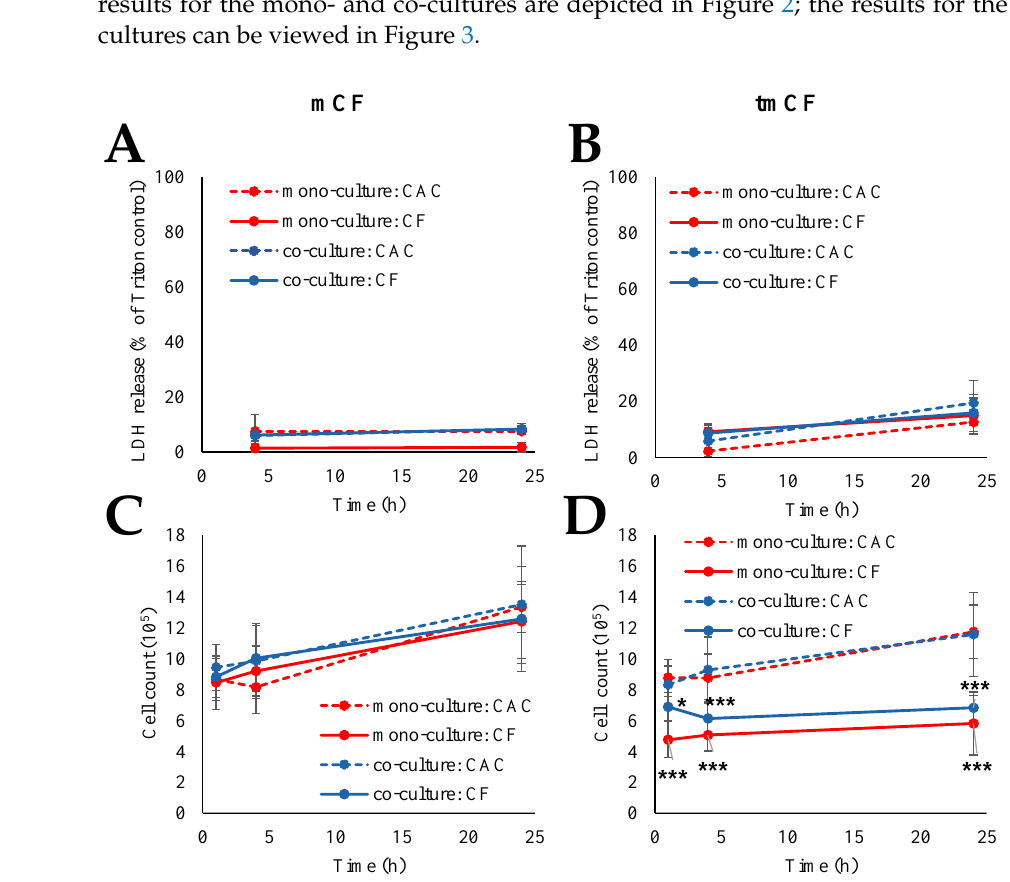
a Aerosol sampled from reactor of AES; b image evaluation of deposited CF on QCM sensor.